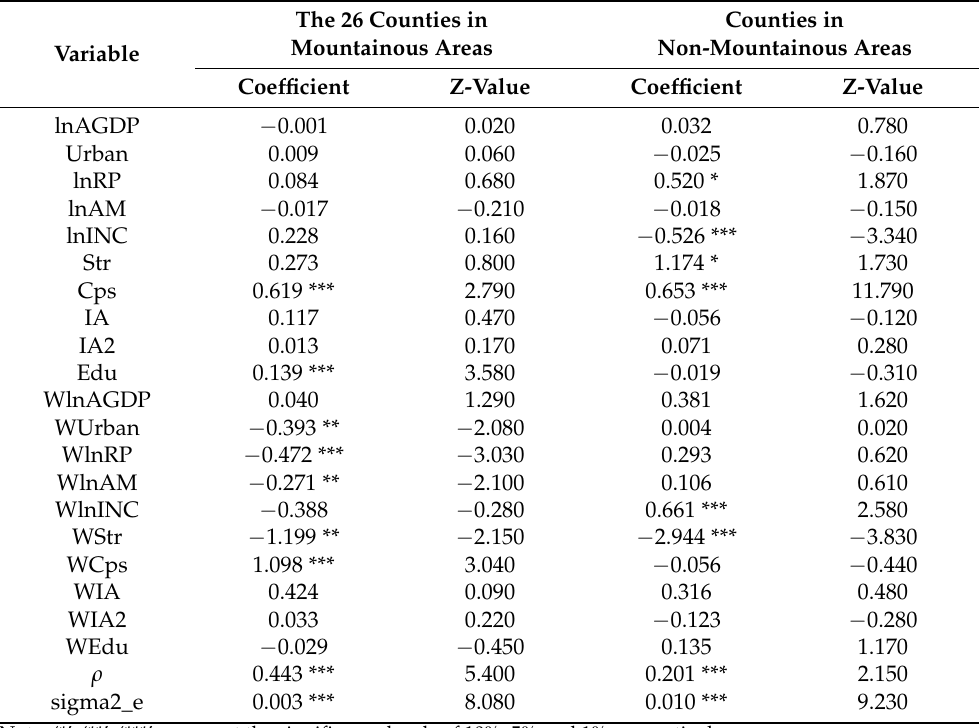
Table 10. Spatial metrological estimation results of the impacts of various variables on the ACESs of the regional samples.